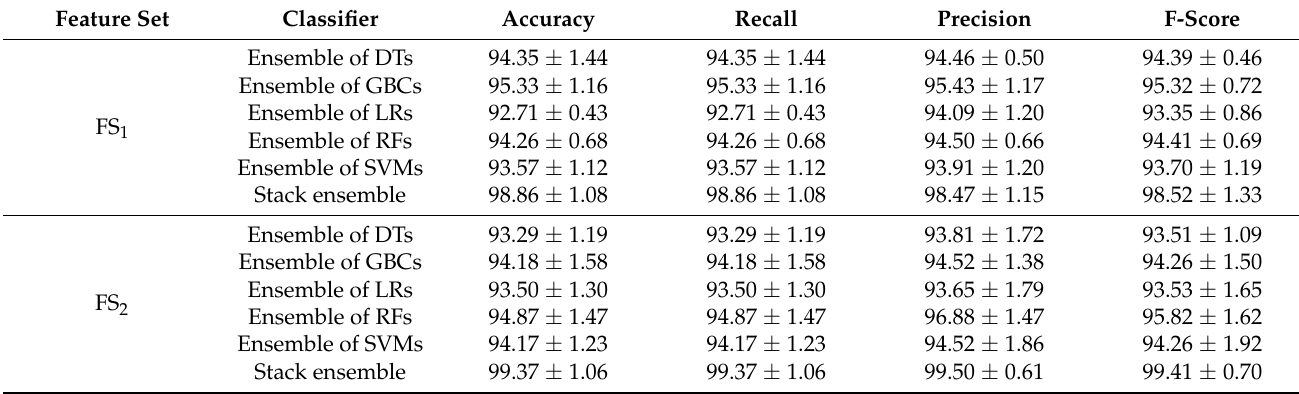
Table 6. Weighted average of performance measures for different classifiers considering different feature